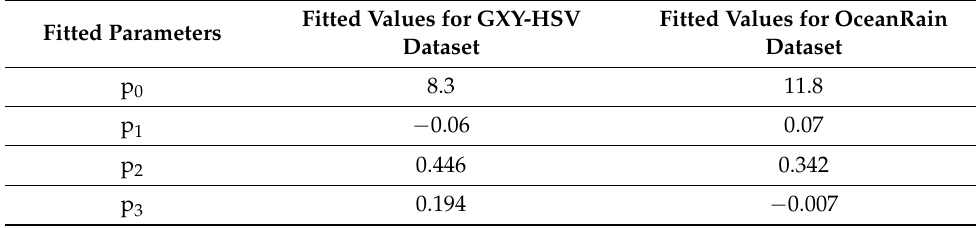
Figure A1. ( a ) Histograms of ∆ log N W for the GXY-HSV (green) and OceanRain (rain) datasets, and their fitted curves; ( b ) the same as ( a ) but with drizzle histograms included (blue). Table A1. Values of the parameters fitted to the histograms in Figure A1a. Fitted Parameters Fitted Values for GXY-HSV Dataset Fitted Values for OceanRain Dataset